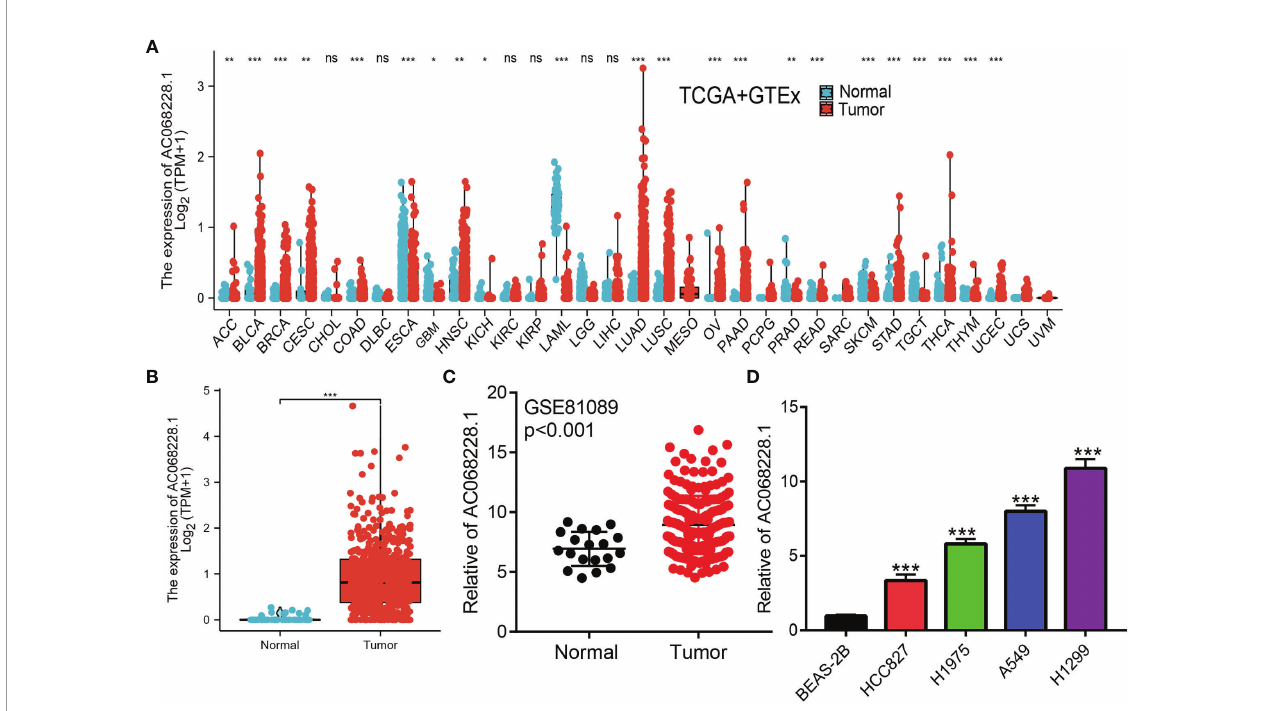
FIGURE 1 | Expression level and prognosis of AC068228.1 in human cancer. (A) Expression of AC068228.1 in normal and tumor tissues in TCGA and GTEx datas. (B) Expression of AC068228.1 in LUAD based on the TCGA dataset. (C) Expression levels of AC068228.1 in lung cancer based on the GEO dataset. (D) The relative expression level of AC068228.1 in lung adenocarcinoma cancerous cell lines, including A549, H1975, HCC827, and H1299 examined by real-time RT-PCR, compared to normal human bronchial epithelial cell line: BEAS-2B. *p < 0.05, **p < 0.01, and ***p <